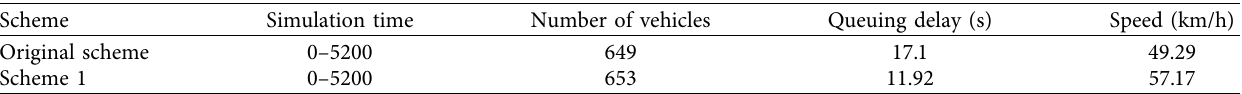
Table 5: Comparison of the output results of the original scheme and scheme 1 after the extension of simulation time.